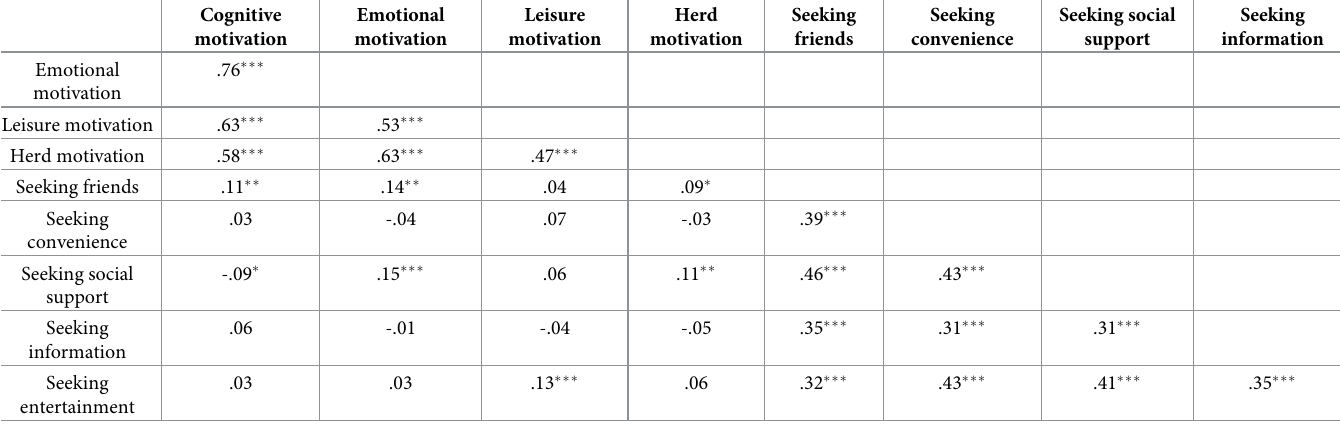
Table 2. Correlations between implicit motivation and explicit motivation used by SNS (n =